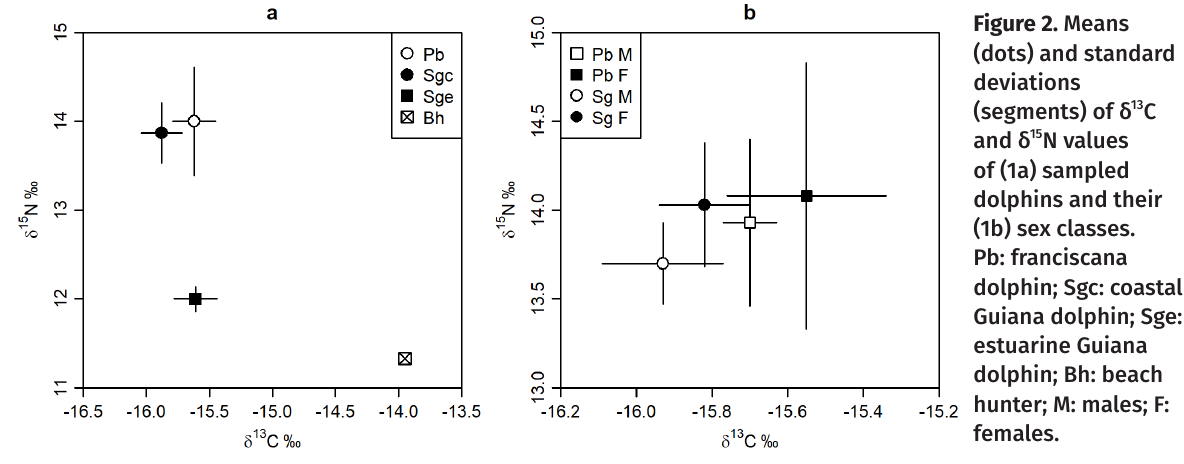
Figure 2. Means (dots) and